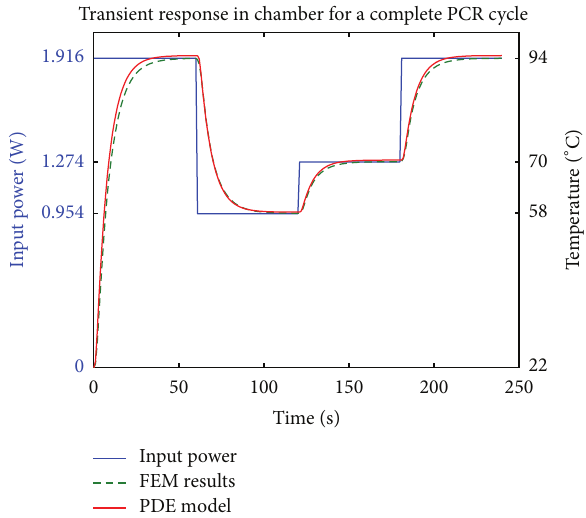
Figure 9: Transient response of the PDE model to a predefined input power trajectory in comparison to the FEM results. The input power represents a complete PCR cycle. There is less than 1% error in dynamic response of the derived PDE model and the complete FEM